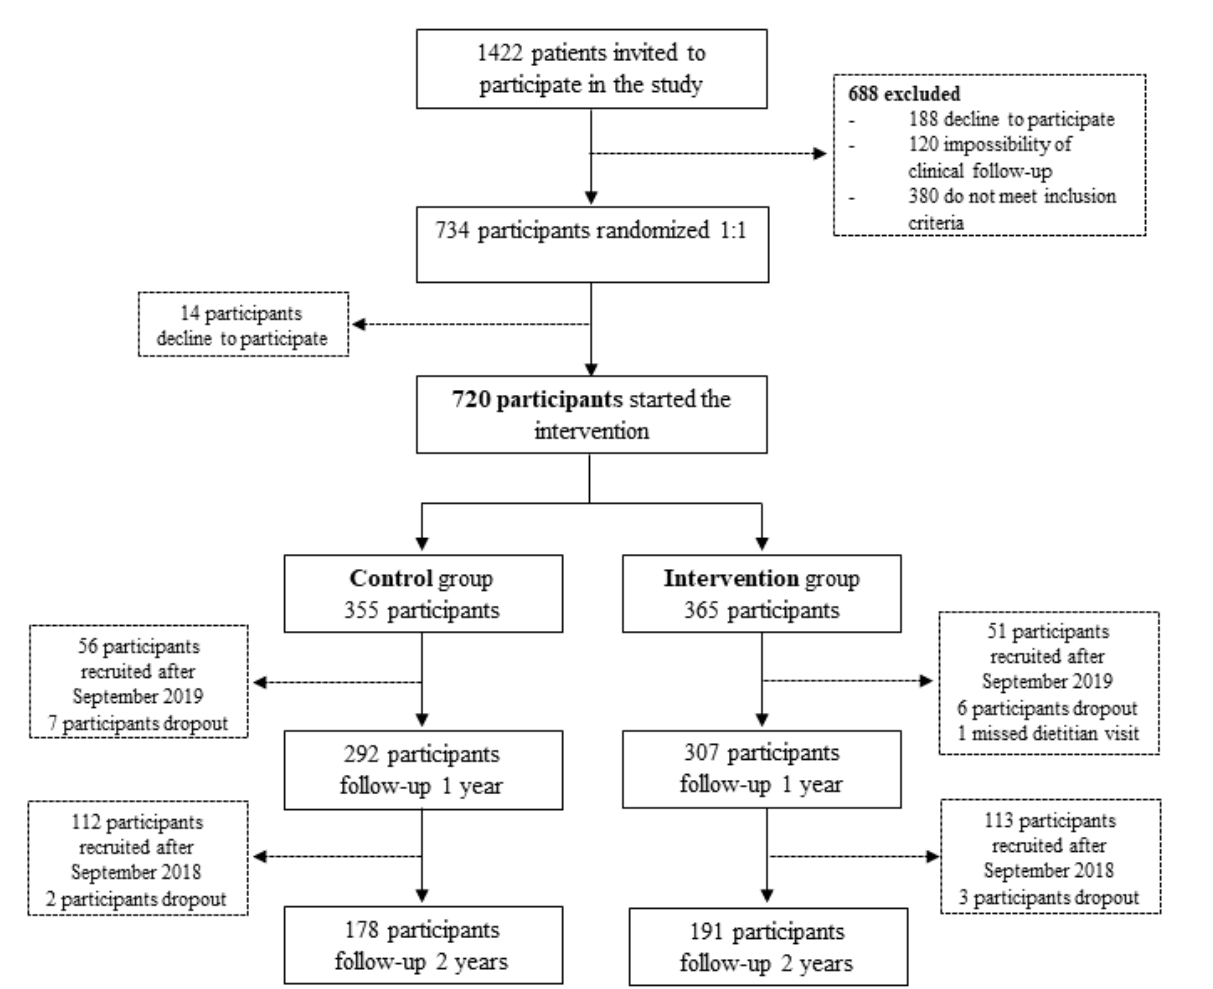
Figure 1. Flowchart of participant screening, recruitment, and